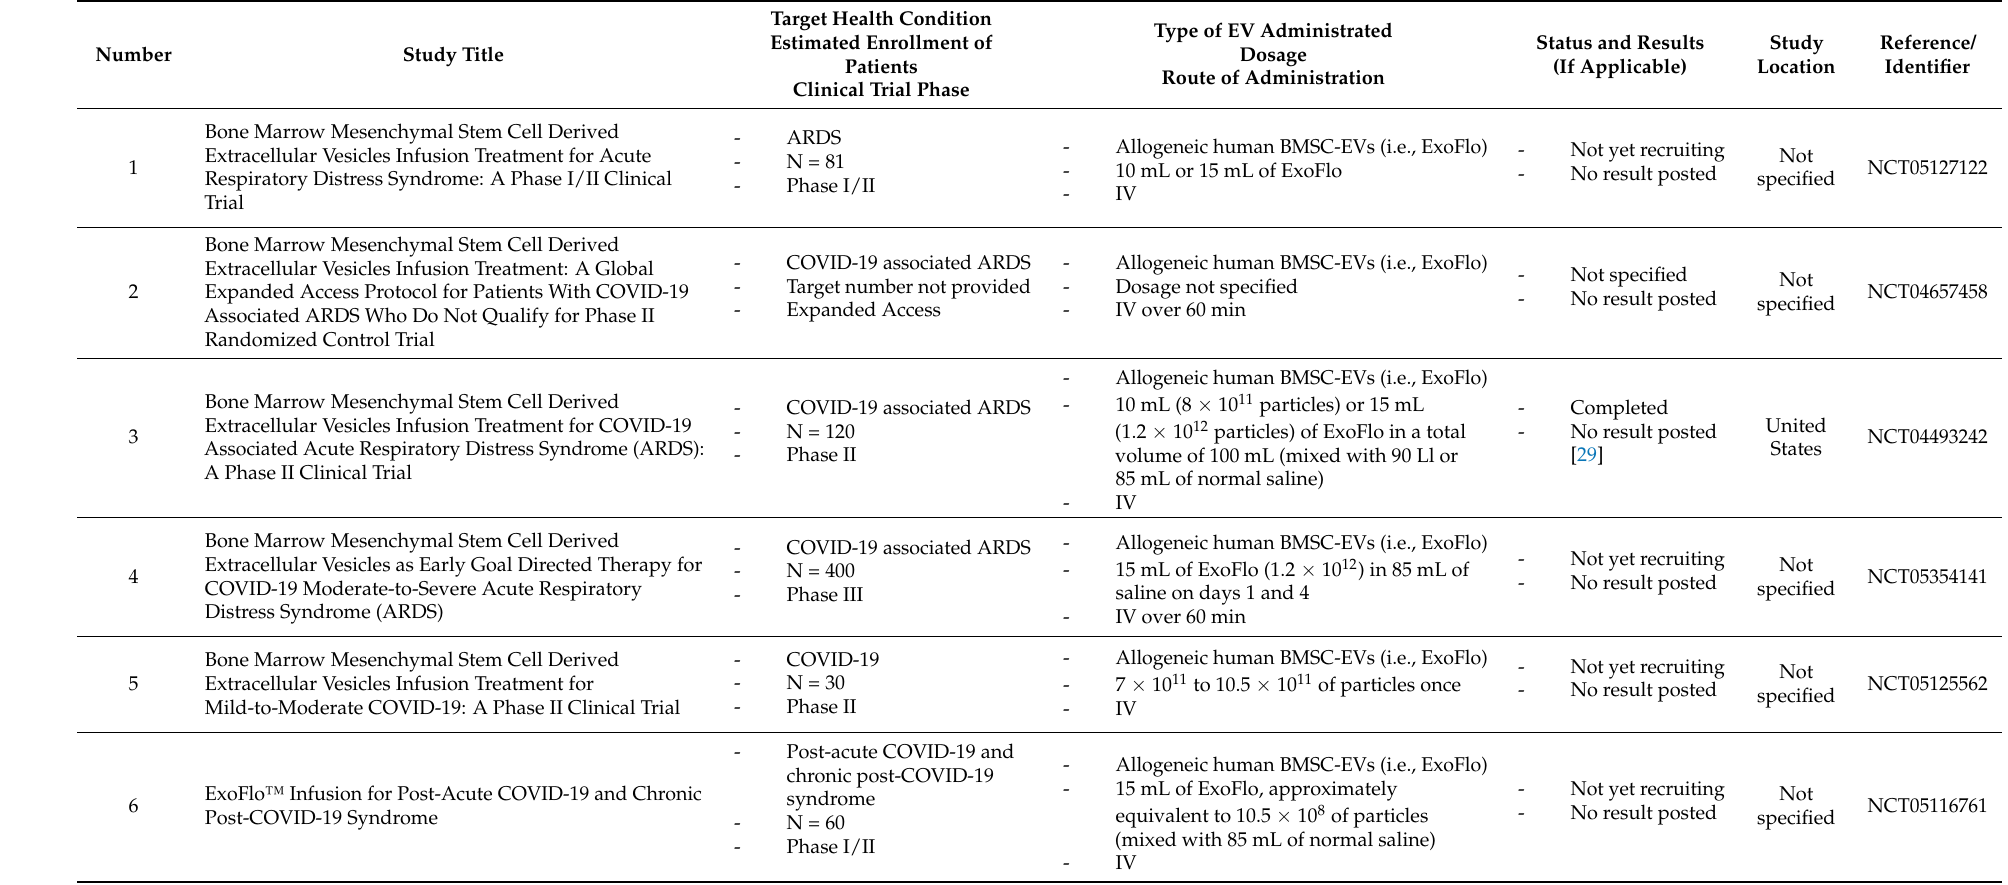
Table 1. List of clinical trials of MSC-EVs registered at www.clinicaltrials.gov (accessed on 30 June